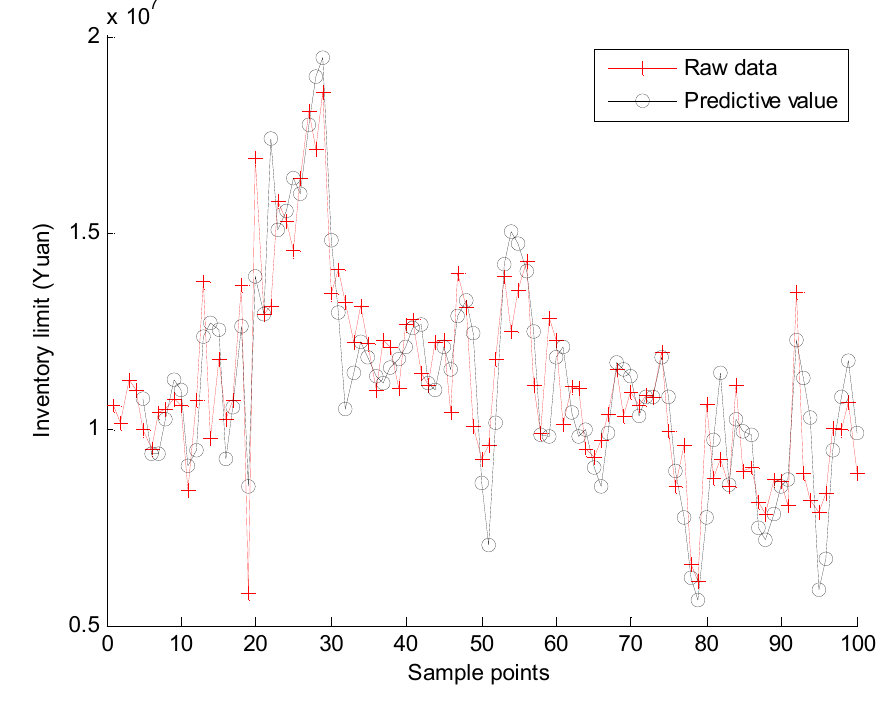
Figure 5. Predictive results of the second moving average method in